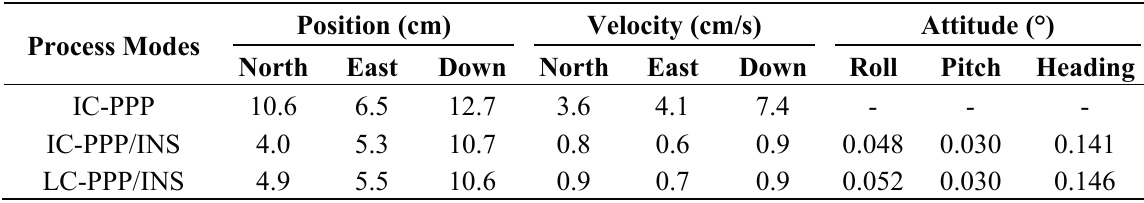
Table 4. RMS of the position, velocity, and attitude of the IC-PPP, IC-PPP/INS and LC-PPP/INS solutions of the vehicle-borne